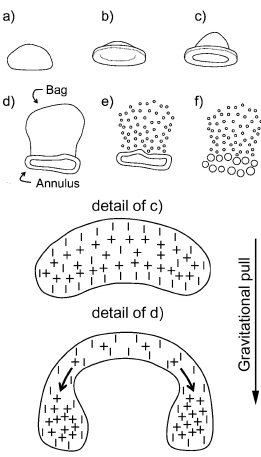
Fig. 1. Theoretical concept of the charge separation mechanism of a falling water droplet. Water bag formation (a–d) , fracture into micro-bubbles (e–f) (modified according to Zilch et al.,